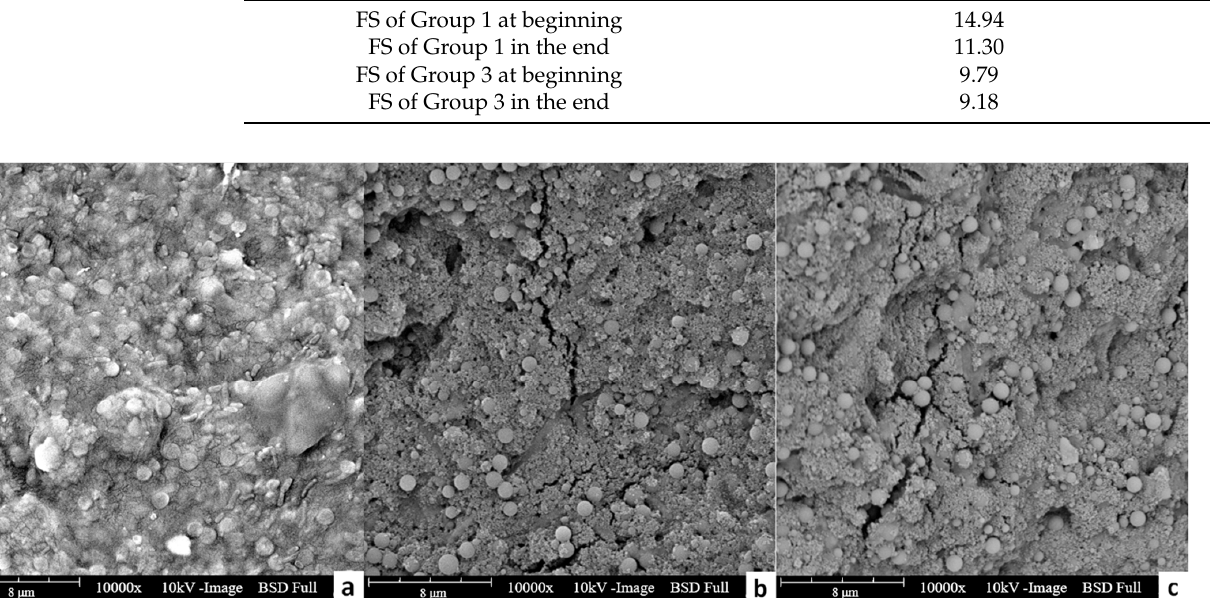
Figure 6. The SEM image of FO membranes after experiments treating feed solutions of in Group 1 ( a ), Group 2 ( b ) and Group 3 ( c ). The magnitude of these SEM images is 10,000×.